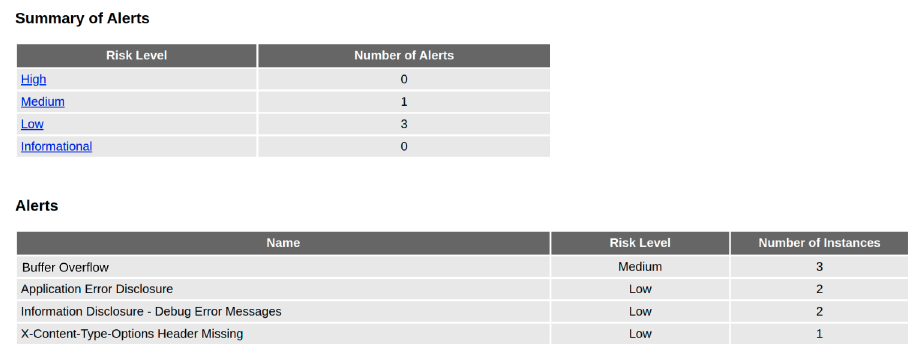
Figure 11. Security test performed on the prototype of the proposed solution